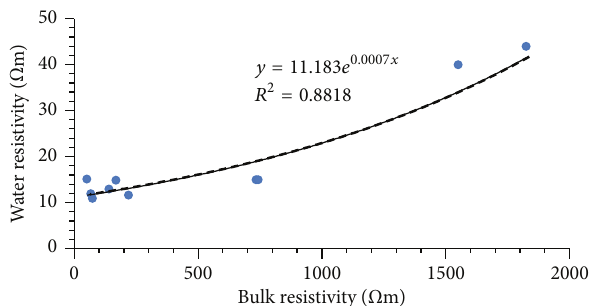
Figure 8: A graph of first layer water resistivity against bulk resistivity.